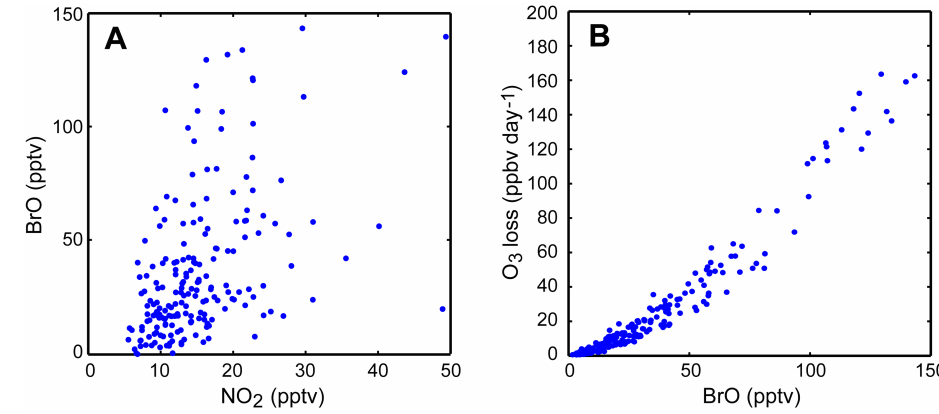
Fig. 14. Results from the chemical box model, constrained by the measurements, assuming a Leighton ratio of ϕ